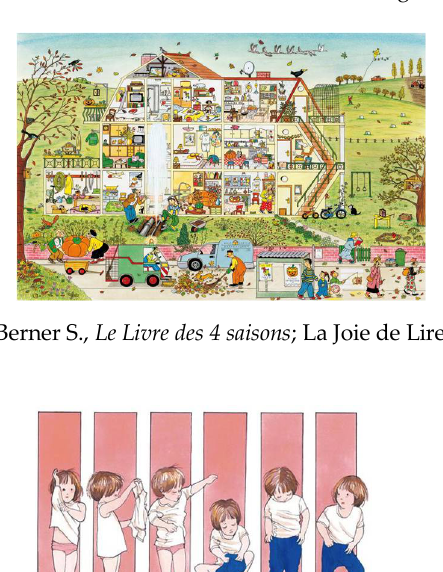
Figure 3. Mitgutsch A., Mein Wimmel Bilderbuch ; Ravensburger, Germania 2010, [3].